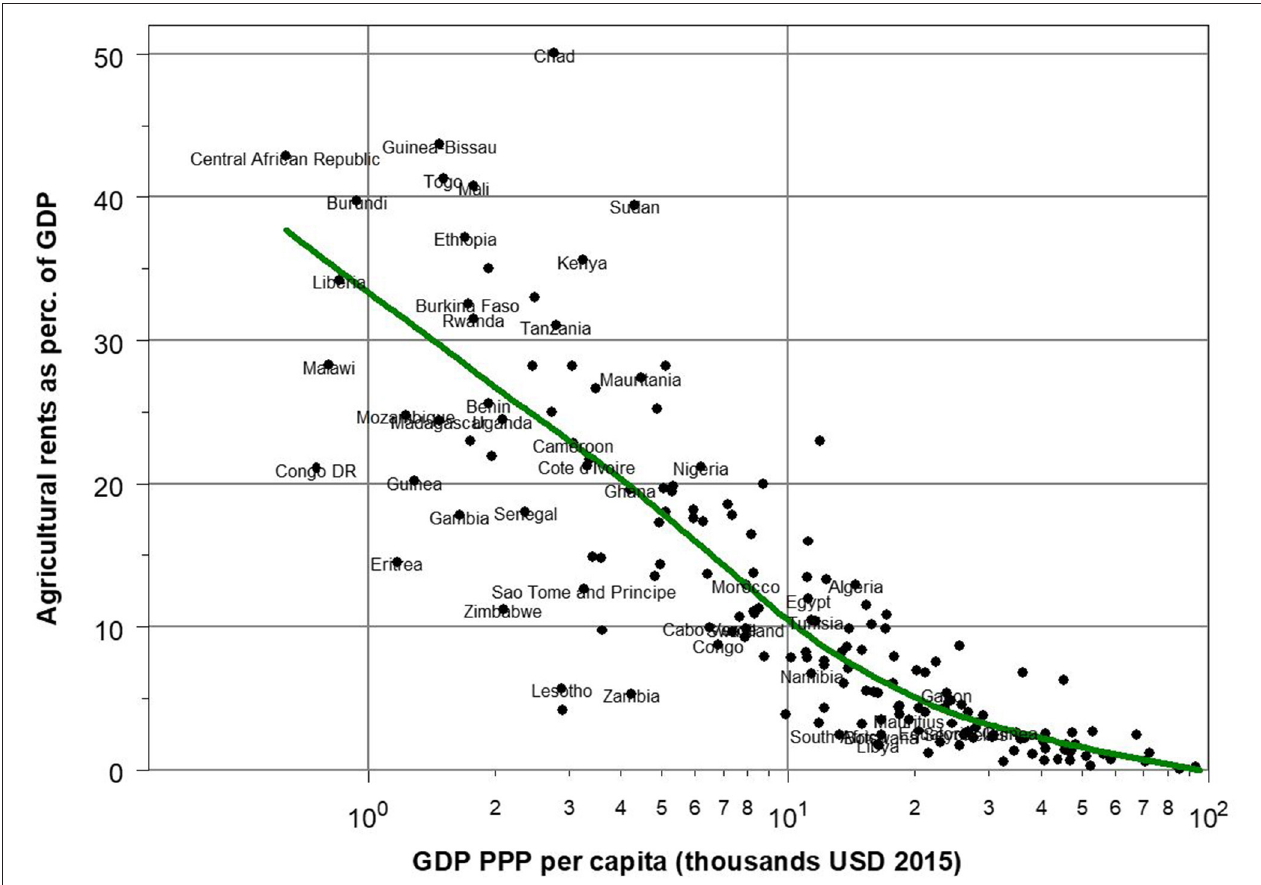
FIGURE 1 | Illustration of the correlation between agricultural rents as percentage of GDP PPP and GDP PPP (data received from: World Bank, 2020). The green line represents the LOESS trend.